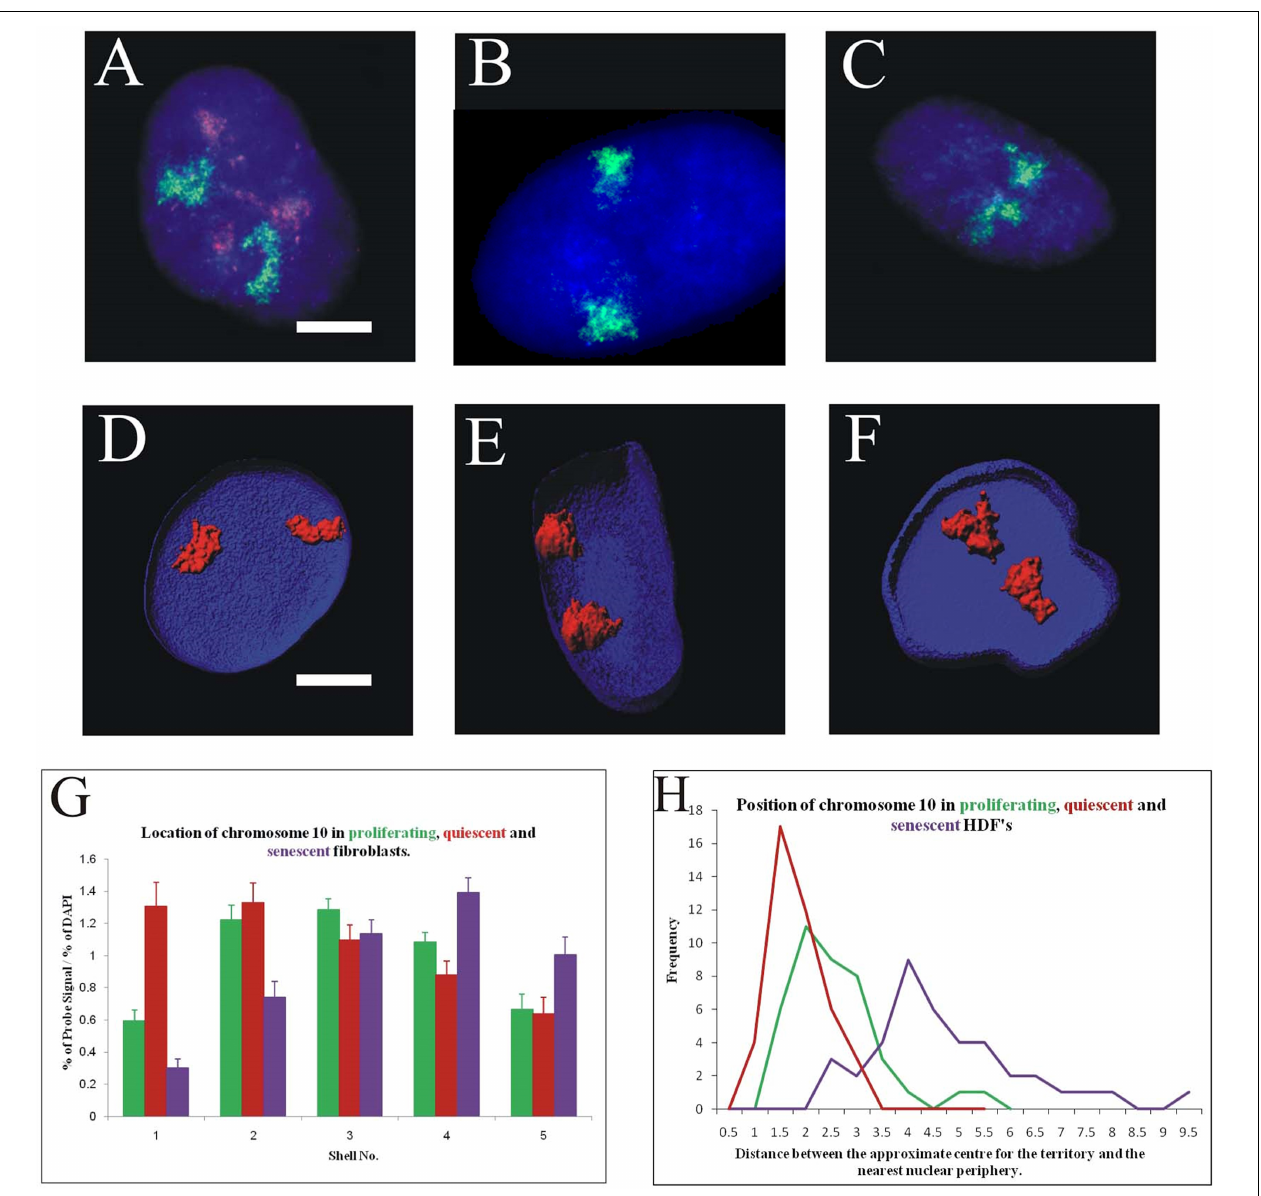
FIGURE 4 | Differential location of chromosome 10 territories in proliferating, quiescent and senescent cell nuclei: Panels (A–C) represent cell nuclei that have been subjected to 2D-FISH, displaying chromosome territories (green) and the proliferation marker pKi-67 (red). Panels (D–F) display 3D reconstructions of cell nuclei that have been prepared for 3D-FISH and optical imaged using a confocal laser scanning microscope. Chromosome territories are in red the nuclei delineated in blue (DAPI). Scale bar = 10 µ m. Panel (G) displays comparative histograms of the position of chromosome 10 in proliferating (green), quiescent (red), and senescent (purple) nuclei, as determined by 2D FISH and erosion script analysis. Error bars represent standard error of the mean (SEM). Panel (H) displays comparative frequency distributions of measurements for the position of chromosome 10 in proliferating (green), quiescent (red), and senescent (purple) in 3D preserved nuclei. Measurements have been made from the geometric centre of each chromosome territory to the nearest edge in 3D. Unpaired, unequal variance, two-tailed Student’s t -test at 95% confidence interval ( p < 0.05) has been